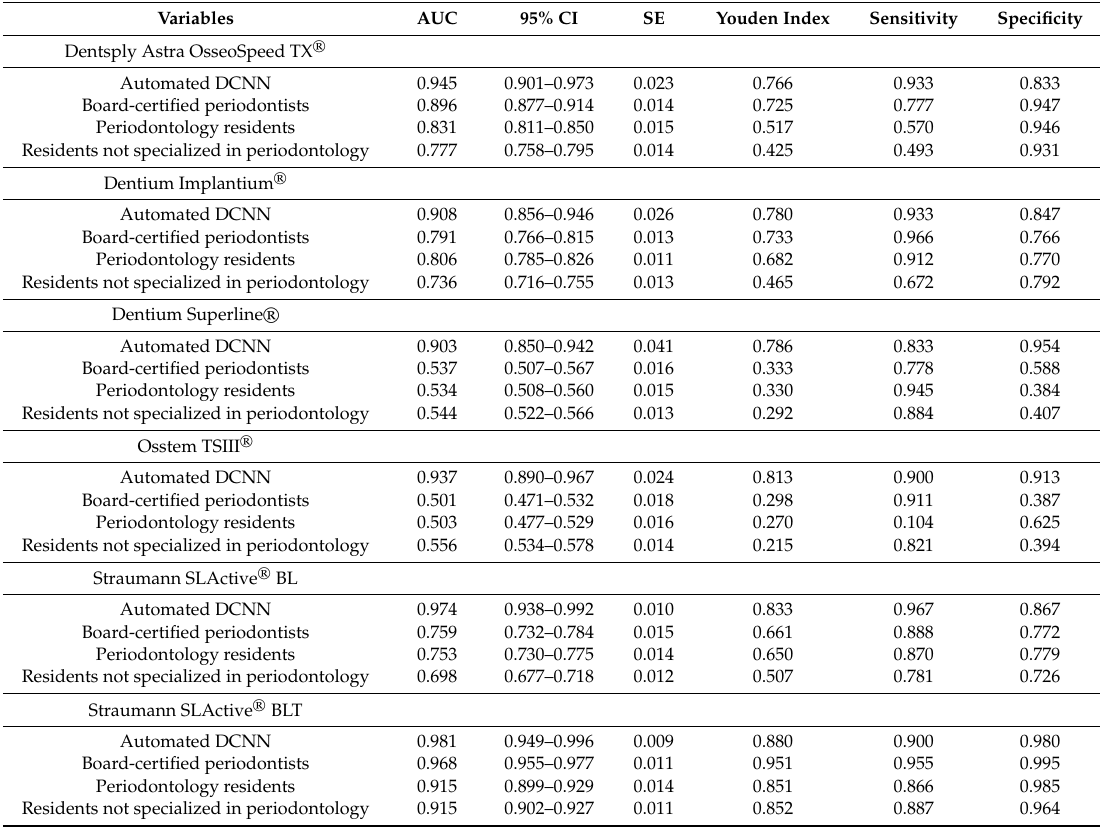
Table 3. Accuracy comparison between the automated deep convolutional neural network and dental professionals for the classification of six types of DISs, based on 180 panoramic and periapical images randomly selected from the training